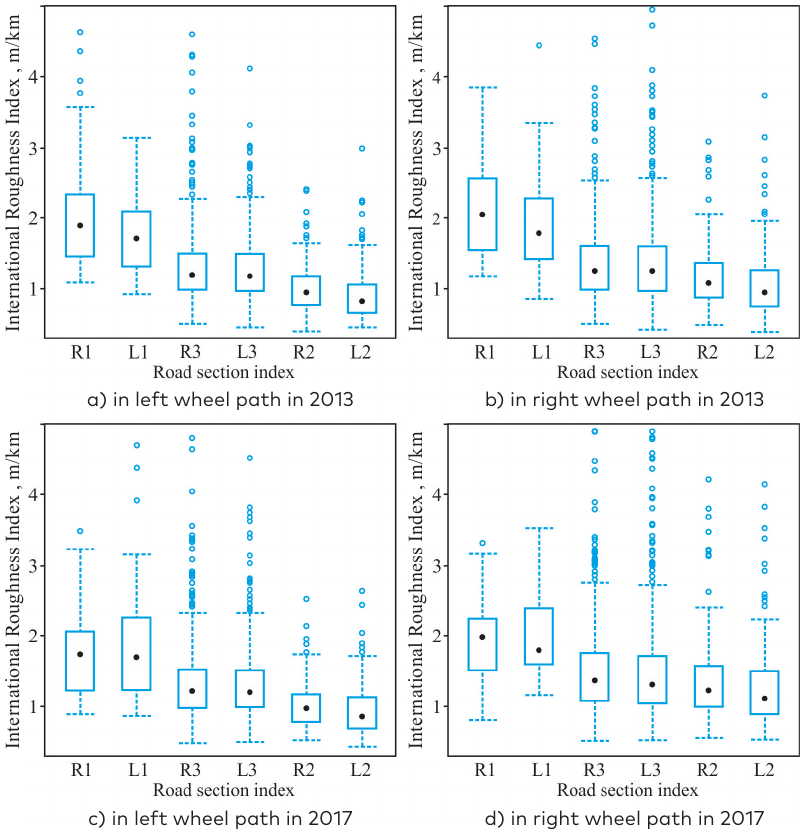
c) in left wheel path in 2017 d) in right wheel path in 2017 Figure 2. International Roughness Index